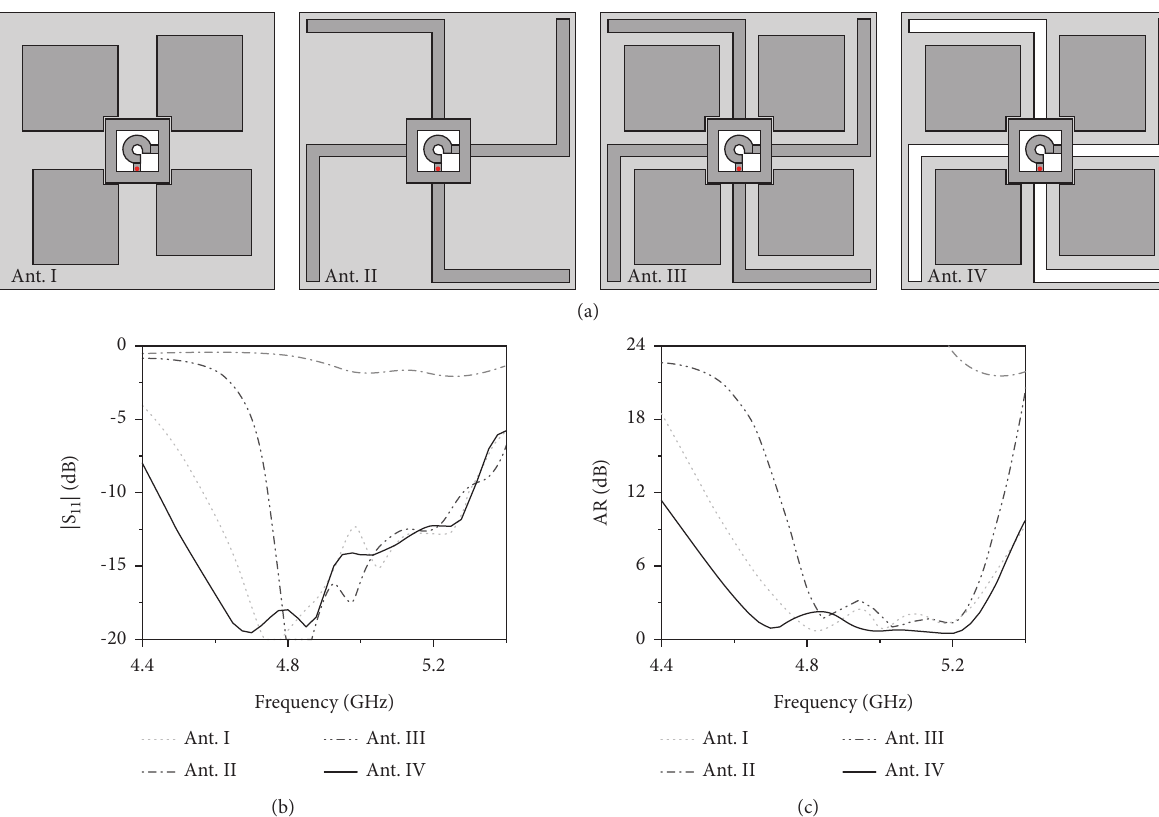
11 | curves and AR curves for different antennas, (a) | S 11 | curves,